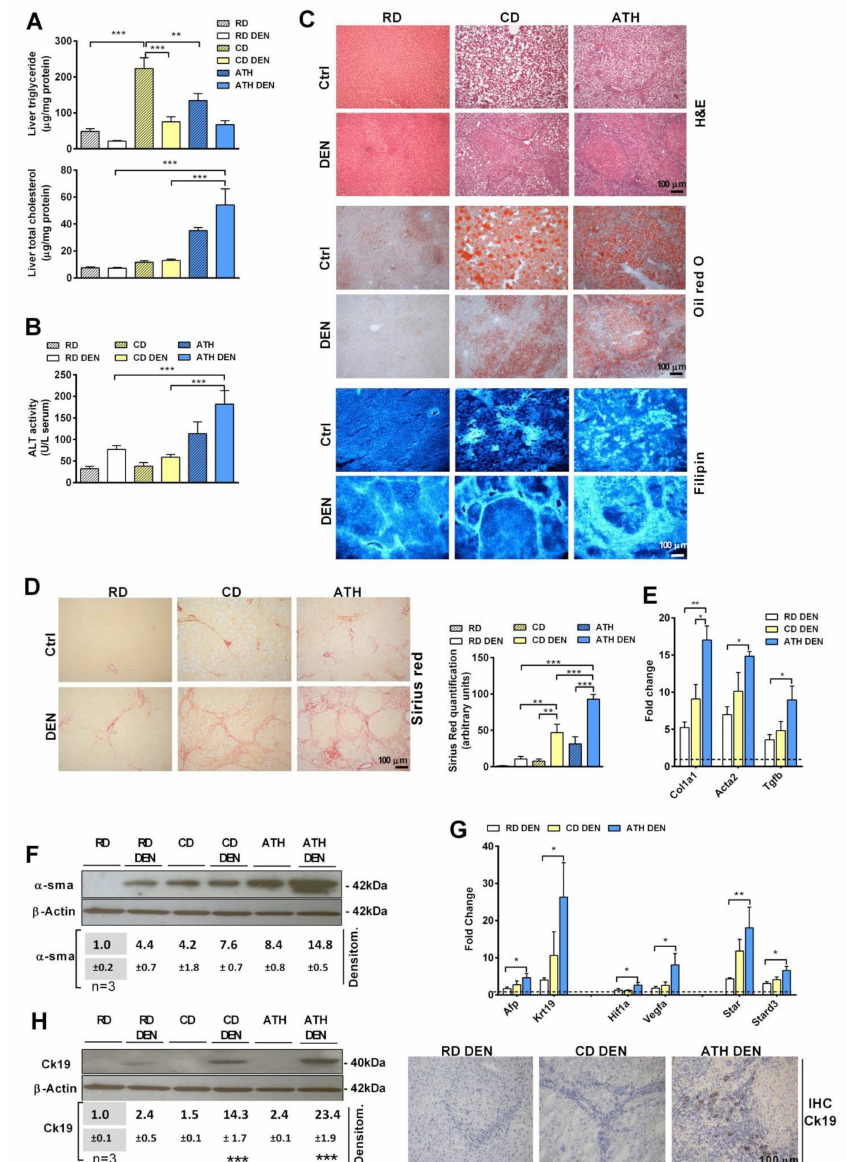
Figure 1. Rats were treated with DEN in the drinking water and fed with RD, CD, or ATH diets for 10 weeks. ( A ) Hepatic triglyceride and total cholesterol composition livers from animals treated with DEN or the vehicle and fed a regular diet (RD), choline-deficient (CD), or a cholesterol-enriched atherogenic diet (ATH) for 10 weeks. ( B ) Transaminase serum levels indicative of liver damage in the animals in the different experimental groups. ( C ) Representative histological staining of liver sections for hematoxylin–eosin (H&E), neutral lipid (Oil Red O), and free cholesterol (filipin). ( D ) Representative histological staining for collagen fibers (Sirius red) and staining quantification of images by ImageJ. ( E ) QPCR determination of fibrosis-related gene expression in the liver. ( F ) Western blot and densitometry of α -SMA in liver tissue, showing significance when compared to their corresponding RD or RD DEN control. Uncropped films from immunoblots in Figure S4. ( G ) QPCR determination of tumorigenesis markers in the livers of DEN-treated animals. ( H ) Representative immunoblot with the densitometry analysis as in ( F ) and representative immunohistochemistry of Ck-19 protein in the livers of animals from different co treated with DEN. Values in qPCR determinations are relative to animals in the RD diet without DEN treatment (value 1.0 depicted as a dotted line) ( N = 5–7). All values are the mean ± SEM. Symbols *, **, and *** denote statistically significant differences in ANOVA test and Bonferroni post-test ( p < 0.05, p < 0.01, and p < 0.001,